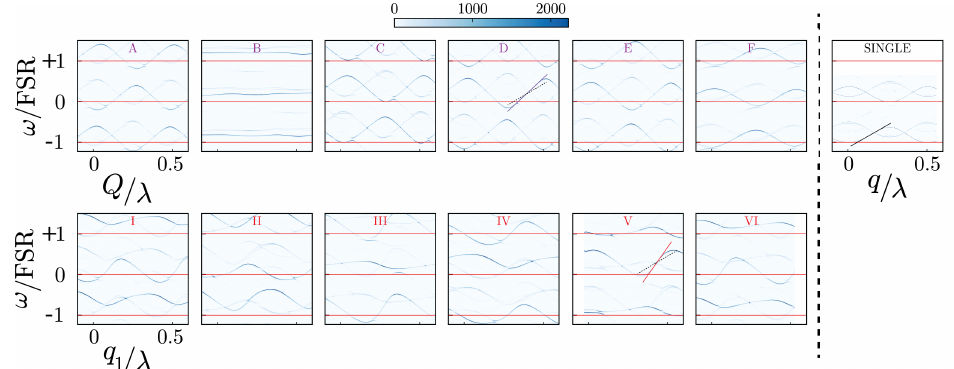
Figure 3. Mode frequency shift normalized to the FSR as a function of the CoM, Q , normalized to the wavelength, for different values of the membrane sandwich length q (panels A–F) and indicated by the lines A–F in Figure 1b. Panel D shows the positions for the highest achievable coupling G max Q indicated by the solid blue line. The panels I–VI represents the mode frequency shift normalized to the FSR, as a function of the membrane position q 1 , normalized to the wavelength, for different values of the position q 2 . Panel V shows the highest achievable coupling G max . For comparison the single 1 membrane result is added as a dotted black line in panels V and D which represents the maximum achievable coupling G max , shown in the panel on the top sing